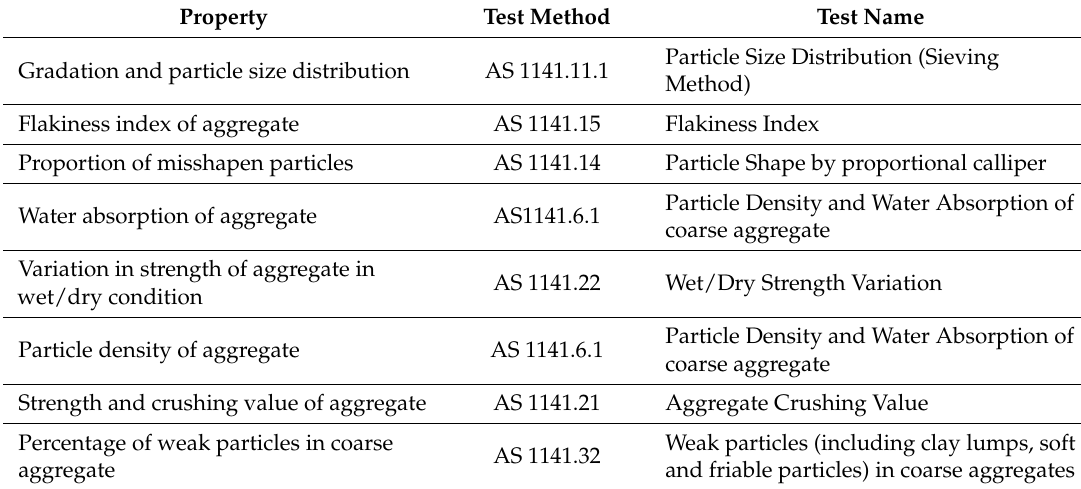
Table 1. The Key Properties Investigated in the Experimental